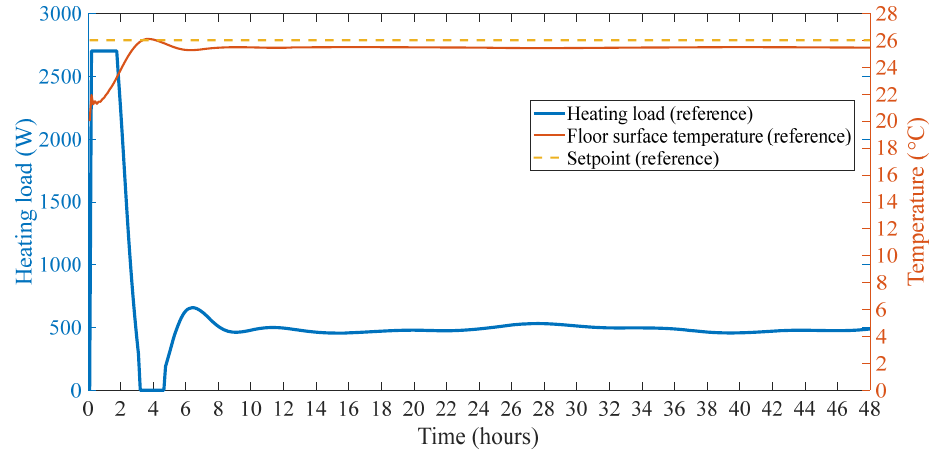
Figure 7. Reference case for floor surface temperature control.